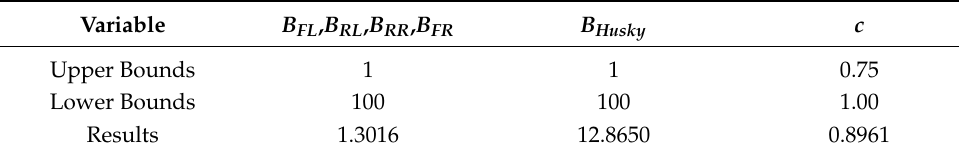
Table 2. Variables adapted by the GA and the resulting values.